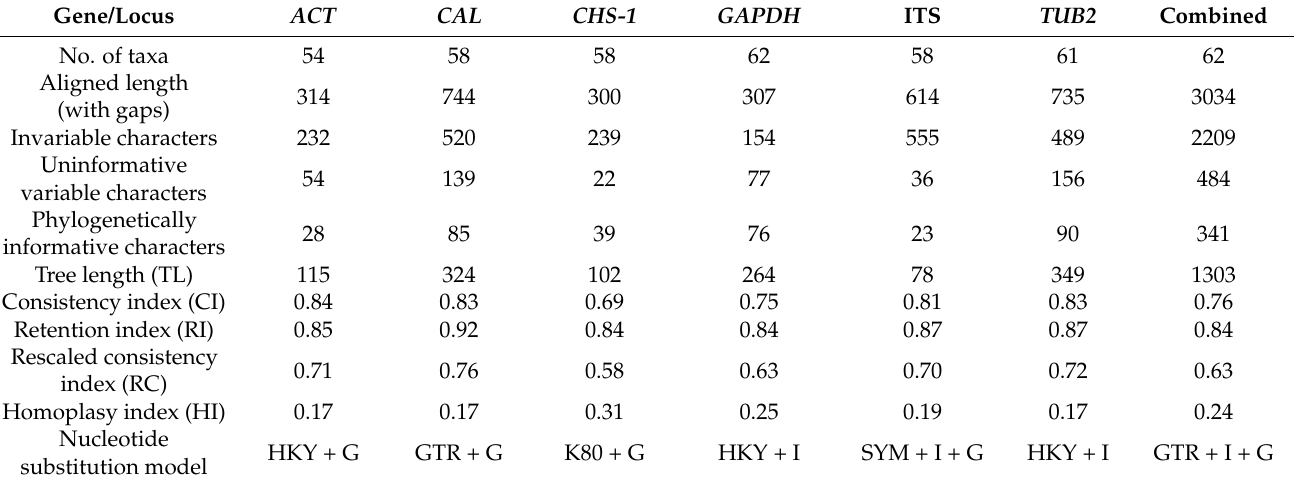
Table 3. Comparison of alignment properties in parsimony analyses of gene/locus and nucleotide substitution models used in phylogenetic analyses of C. gloeosporioides species